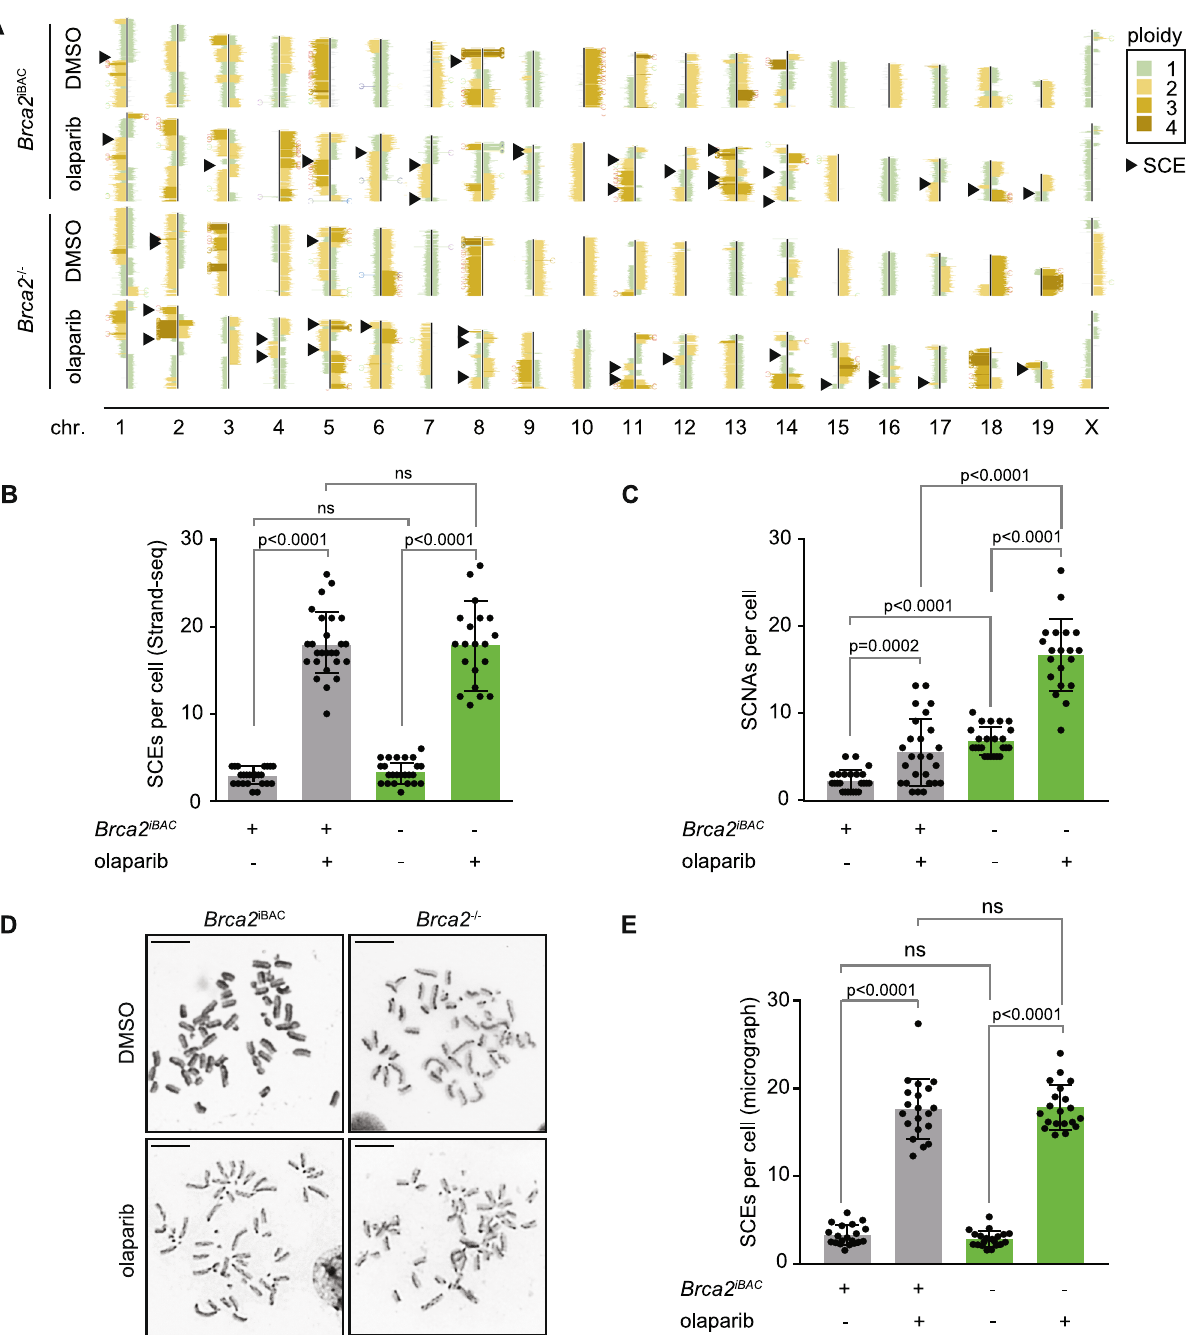
Fig.1|Olaparib-treatmentinducessister-chromatidexchangesin Brca2 wtand Brca2 -mutantcancercells.A RepresentativeStrand-seq librariesof Brca2 -/- cells or Brca2 iBAC cells, treated with DMSO (top) or olaparib (bottom). Black arrow- heads indicate SCEs. B , C Brca2 -/- cells or Brca2 iBAC cells were treated with DMSO or olaparib. Quanti fi cation of SCEs (panel B) and CNVs (Panel C) per cell was done in n =23 ( Brca2 iBAC , DMSO), n =26 ( Brca2 iBAC , olaparib), n =24 ( Brca2 -/- , DMSO), and n =19 ( Brca2 -/- , olaparib) libraries. Means and standard deviations